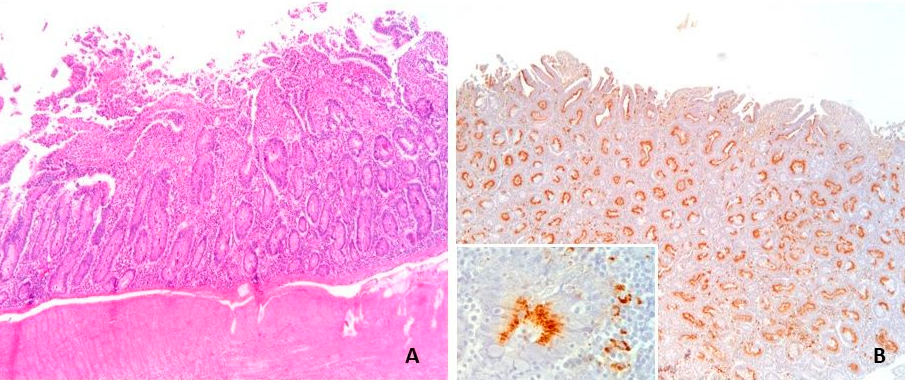
Figure 6. Swine ileum; porcine intestinal adenomatosis (PIA). Case ID 22: ( A ) Moderate hyperplasia of the crypts and ( B ) immunohistochemical positive stain to L. intracellularis appreciable (inset) both in the cell crypts and in interstitial macrophages. ( A , B ): 6.3 × . Co-infection of L. intracellularis with PCV2 and co-localization of lesion with the relative aetiology ( L. intracellularis in the cytoplasm of intestinal crypts and PCV2 stain in the centre of lymphoid follicles and multifocally in macrophages in the lamina propria) was objectively assessed in two out of four acute cases and two out of 24 chronic